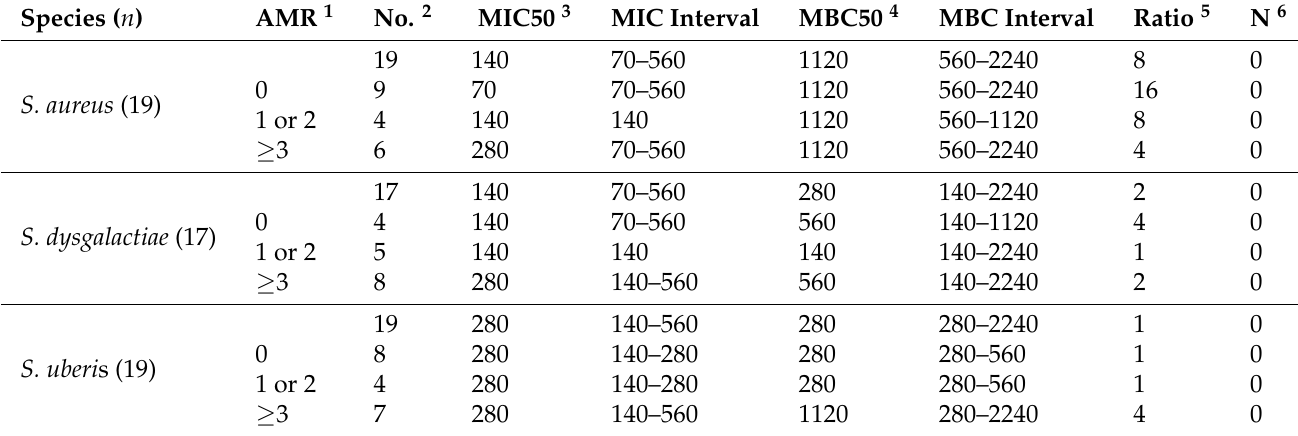
Table 3. MIC and MBC intervals, as well as MIC50 and MBC50 ( µ g/mL) values, of reuterin against Staphylococcus and Streptococcus causing mastitis.